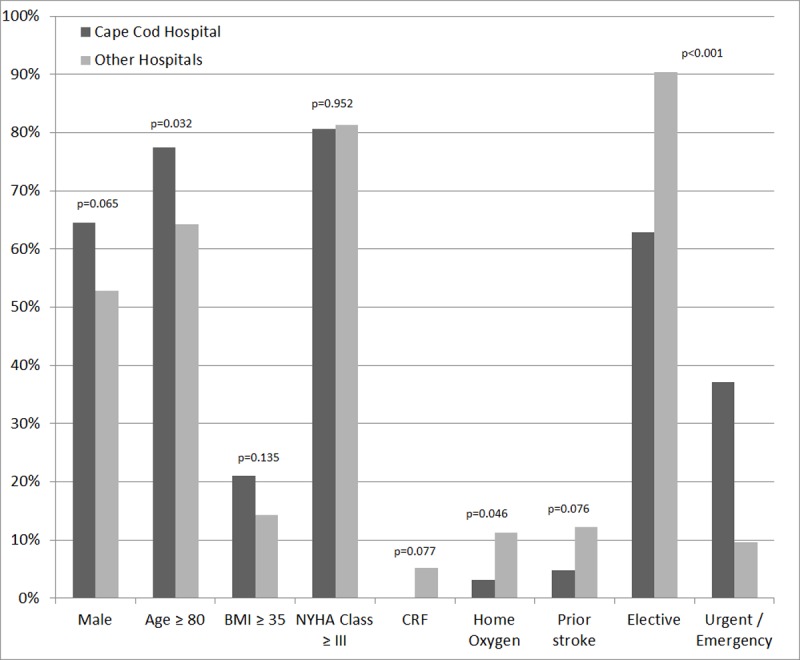
Comparison of patients’ demographic and co-morbidity between Cape Cod and other hospitals.